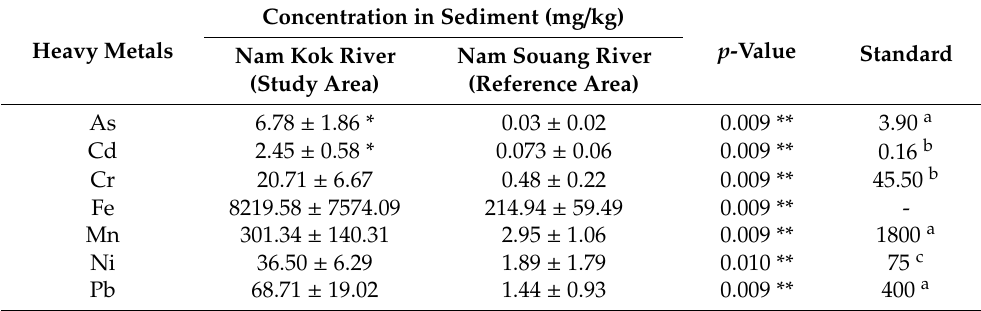
Table 4. Heavy metal and metalloid concentrations in sediment samples (n = 10) from in the Nam Kok river near the Sepon gold-copper mine as the study area and the Nam Souang river as reference area.